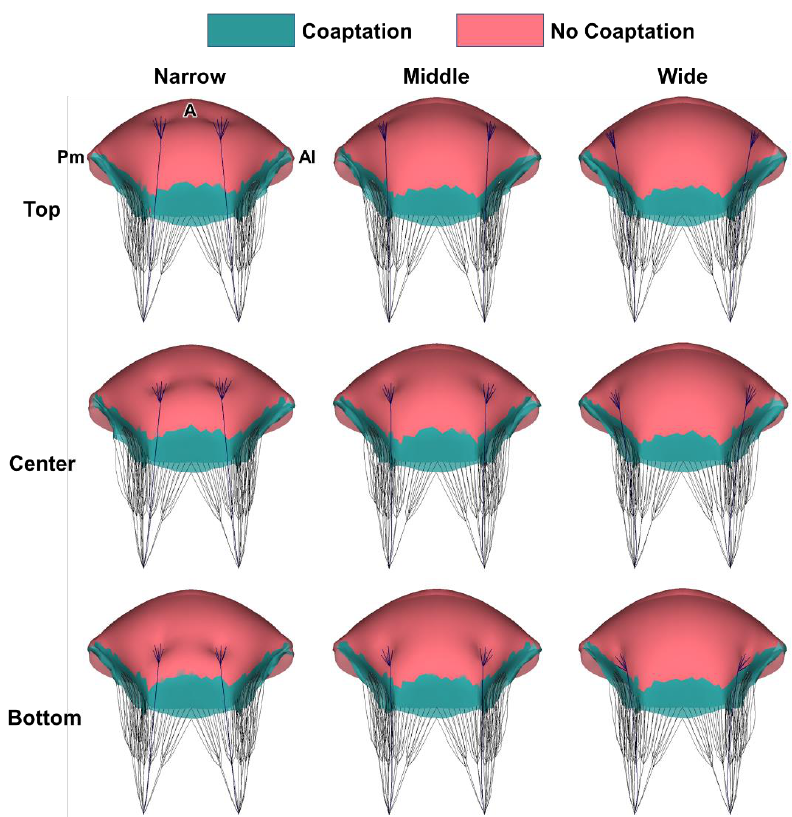
Figure 3. Leaflet coaptation distributions at peak systole with respect to alteration of the SC insertion location (anterior viewpoint). A—anterior; Al—anterolateral; Pm—posteromedial.